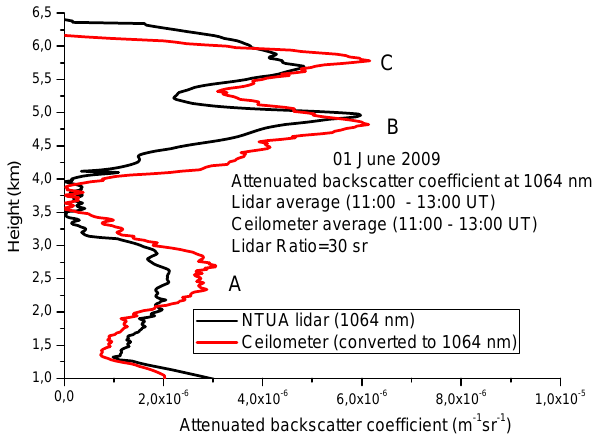
Fig. 10. Comparison of the attenuated backscatter coefficient pro- files (in m − 1 sr − 1 ) obtained by the Vaisala ceilometer and the NTUA Raman lidar system (11:00–13:00UT) on 1 June